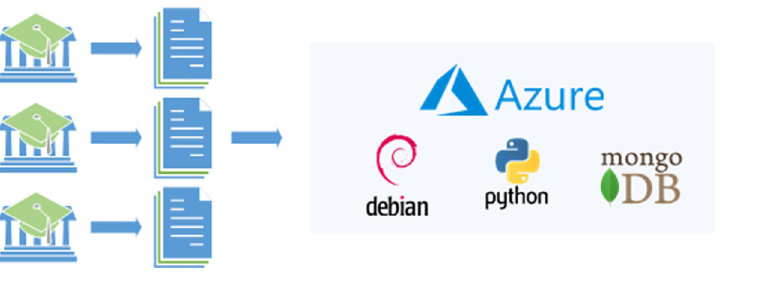
Fig 4. Technological stack.